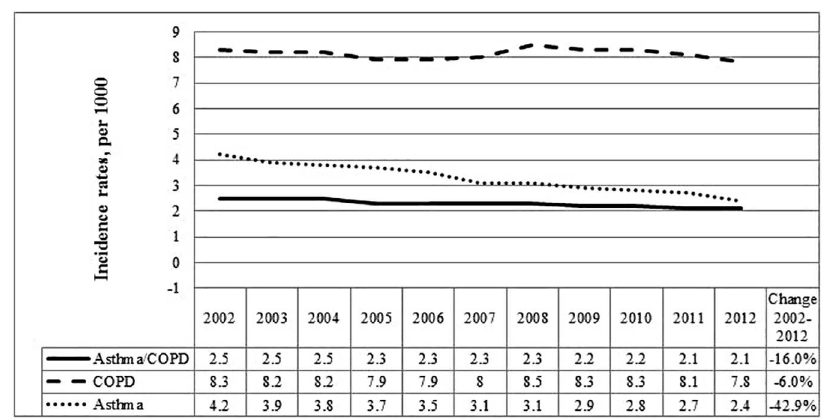
Fig 2. Age and sex standardized incidence rates (per 1000 individuals) for COPD, asthma and concurrent physician-diagnosed asthma and COPD over time among adults 35 years and older in Ontario, Canada.